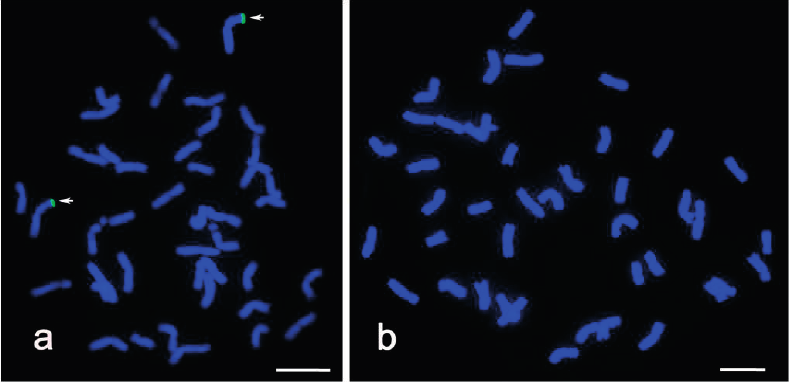
Figure 2. GISH pattern of lines 03W006, the wheat- Thinopyrum intermedium recombinant control ( a ) and CH09W89 ( b ) at mitosis using Th. intermedium genomic DNA as the probe. Arrows indicate alien chromatin. Scale bar = 10 μ